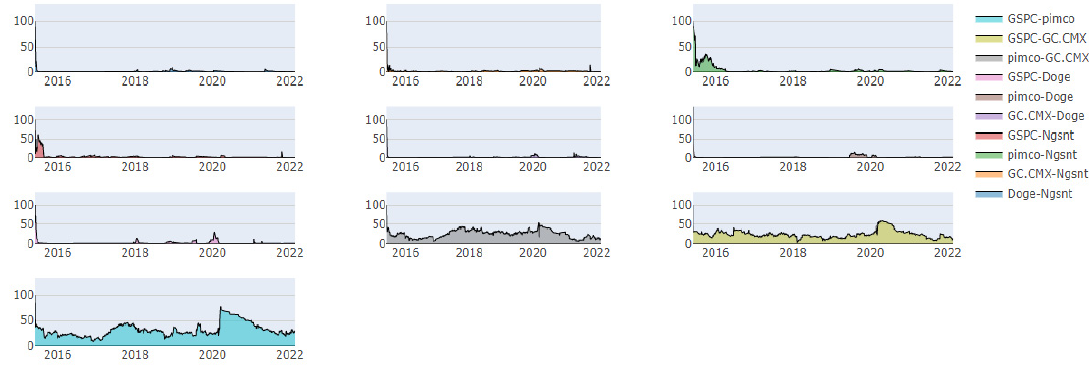
Figure 3. Dynamic pairwise connectedness index (PCI).